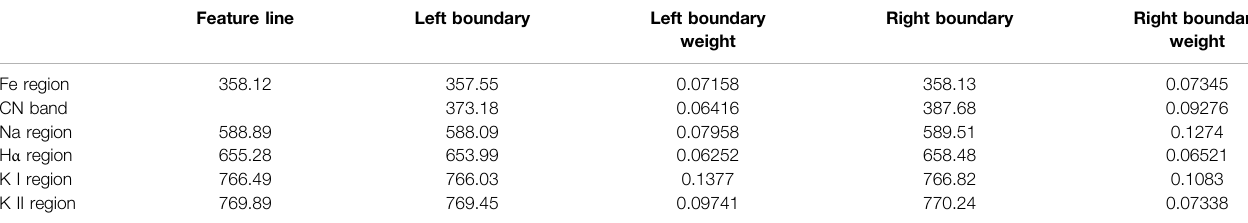
TABLE 6 | Line regions and their boundaries used to calculate areas. Feature line